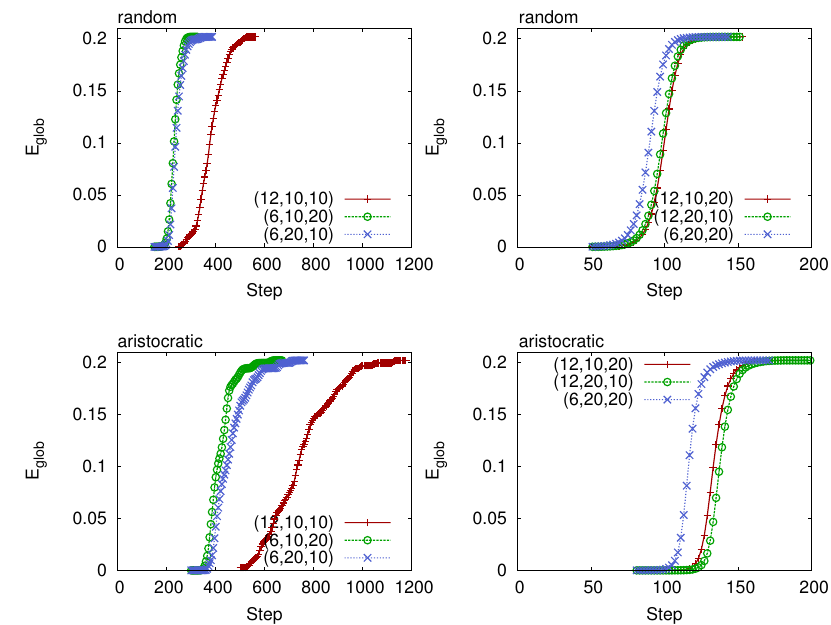
Figure 14. Behavior of the network’s E glob with two different cost levels: C s = 1200 ( left panels ) and C s = 2400 ( right panels ) for the VirtualTourist social network, broadcast model . In total, six configurations are considered. The one that has higher attractiveness is the favored one because can reach the efficiency of the original network faster than the others.